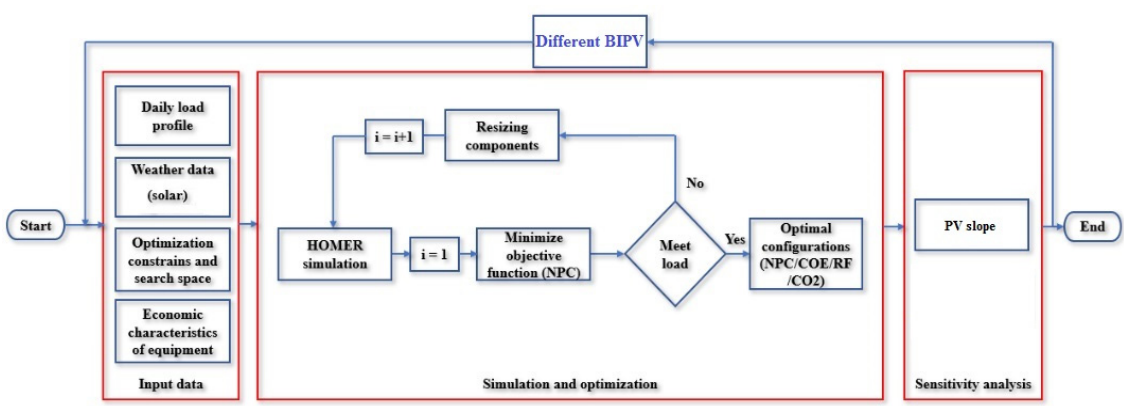
Figure 7. Optimization flowchart for the present work by HOMER software .